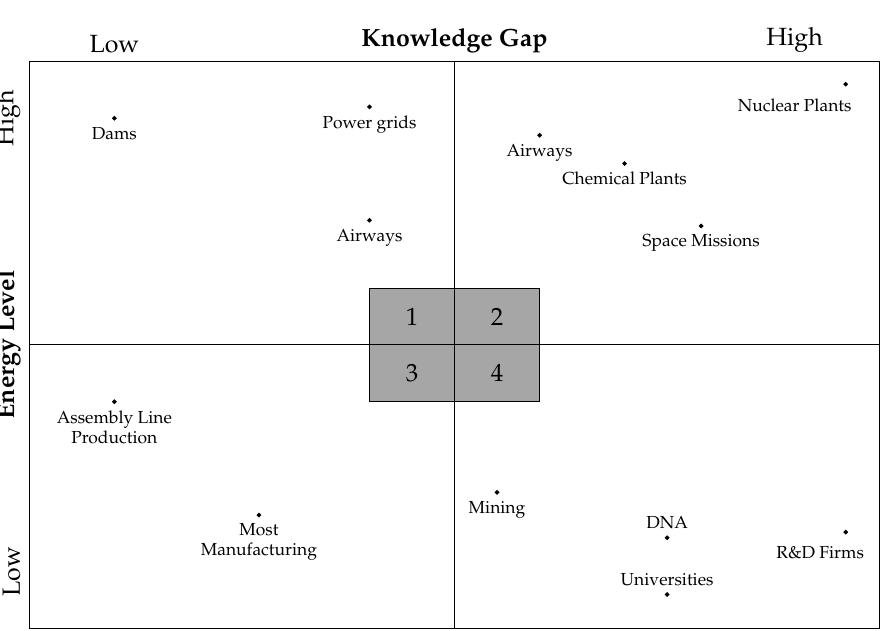
Figure 1. Plotting energy level against knowledge gap to create 4 quadrants. Systems in quadrant 3 have the lowest damage potential, and damage is limited to 1st parties. Systems in quadrant 4 have moderate damage potential up to 4th party victims, systems in quadrant 1 have high damage potential up to third party victims, and systems in quadrant 1 have catastrophic risk potentials to 4th party victims. Based on Shrivastava et al. [9] (p.